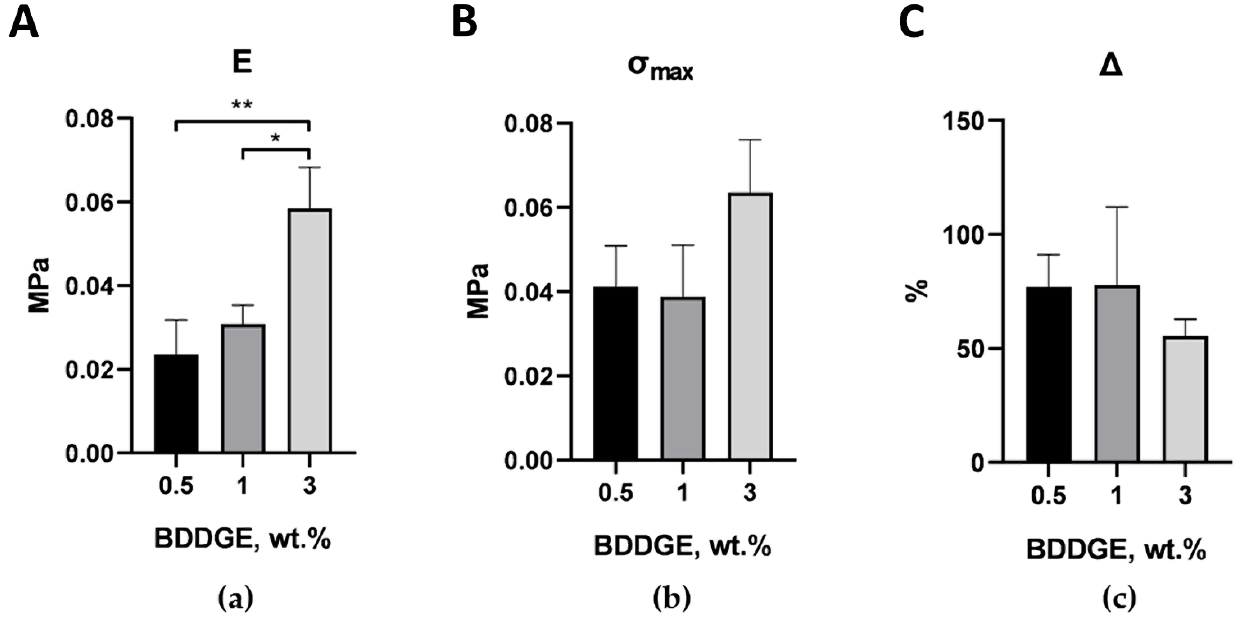
Figure 2. Tensile test results for ELS СOL samples immersed in isopropanol with 15 wt.% BDDGE for 6 days and in PBS for 1 day: ( а ) Young’s modulus, ( b ) tensile strength, ( c ) maximum elongation. * p < 0.05, ** p < 0.01 in Student ’ s t-test; data are the mean ± SD of at least 3